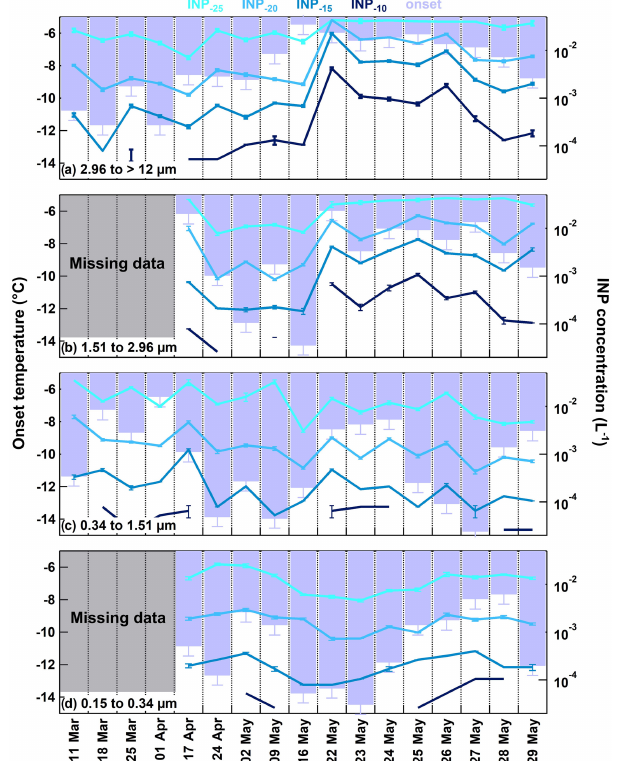
Figure 4. Onset freezing temperatures and INP concentrations at − 10, − 15, − 20, and − 25 ◦ C for DRUM stages (a) A, (b) B, (c) C, and (d) D for each sample collected during INPOP. Dark grey shad- ing represents missing data. Error bars for the onset temperature represent the probe uncertainty and the plate correction and stan- dard deviation for the INP concentrations.